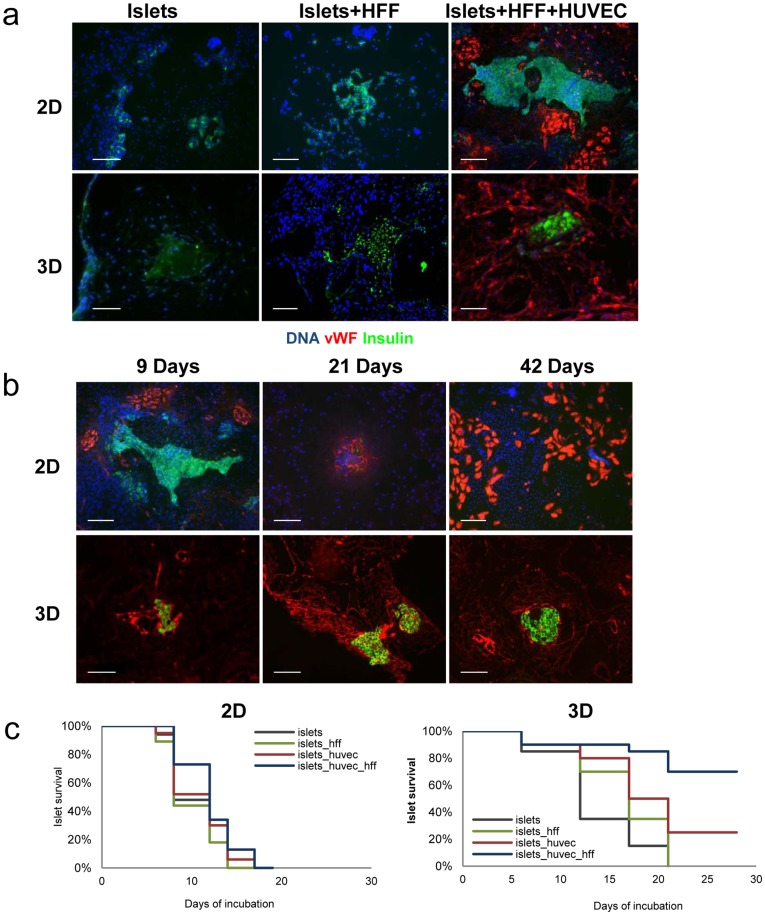

In vitro vascularization of engineered pancreatic tissue: 2D versus 3D growth environments.20 isolated mouse islets seeded alone, with HFF or with HFF and HUVEC were either grown on 3D polymer scaffolds or on 2D ECM-coated plates for up to 28 days. Scaffolds and plates were triple-stained with anti-vWF (red), anti-insulin (green) antibodies and DAPI (blue). (a) 10-day old, immunostained sections; scale bar-200 µm. (b) Staining of 9-, 21- and 42-day-old sections. Scale bar-200 µm (c) Islet survival in 2D and 3D cultures was determined by quantification of the number of viable islets under light microscope using trypan blue, insulin and DAPI staining for the 2D-plated islets and immunofluorescently via insulin- and DAPI-stained islets for 3D scaffolds.